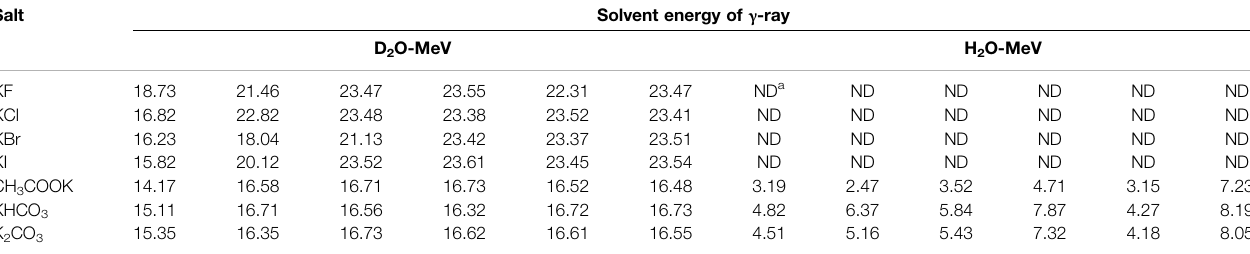
TABLE 3 | Discrete Laplace transformation of γ -ray spectrum in both solvents in selected salts. Salt Solvent energy of γ -ray D 2 O-MeV H 2 O-MeV KF